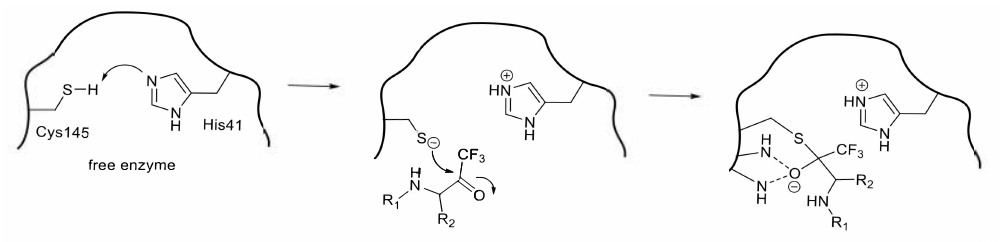
Figure 5. Proposed mechanism of inhibition by a trifluoromethyl ketone compound.